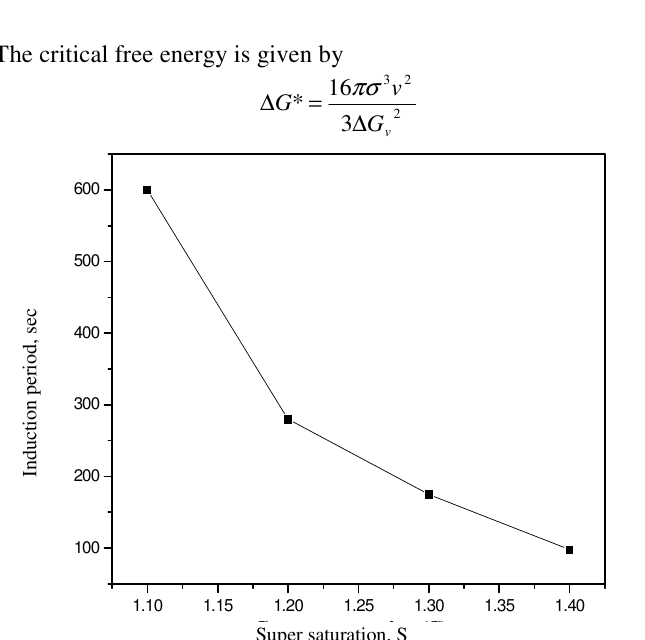
Figure 3. Variation of induction period with super saturation ratio for ZSHH solution. ZSHH possesses the interfacial energy ranging from 1.7049 to 3.5368 mJ/m 2 . The energy of formation ( ∆ G * ) and radius (r * ) of the critical nucleus of ZSHH were found to be from 2.8125 to 2.0149 kJ/mol and from 1.985 nm to 1.1665 respectively at different